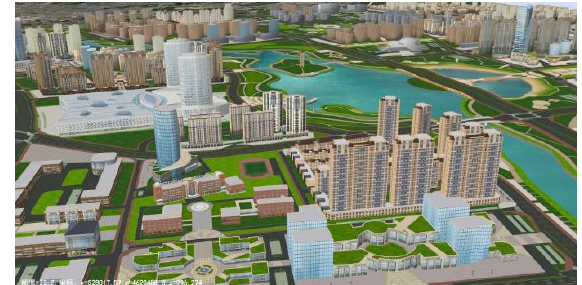
Figure 7. The efficacy of Kuerle Data rendering